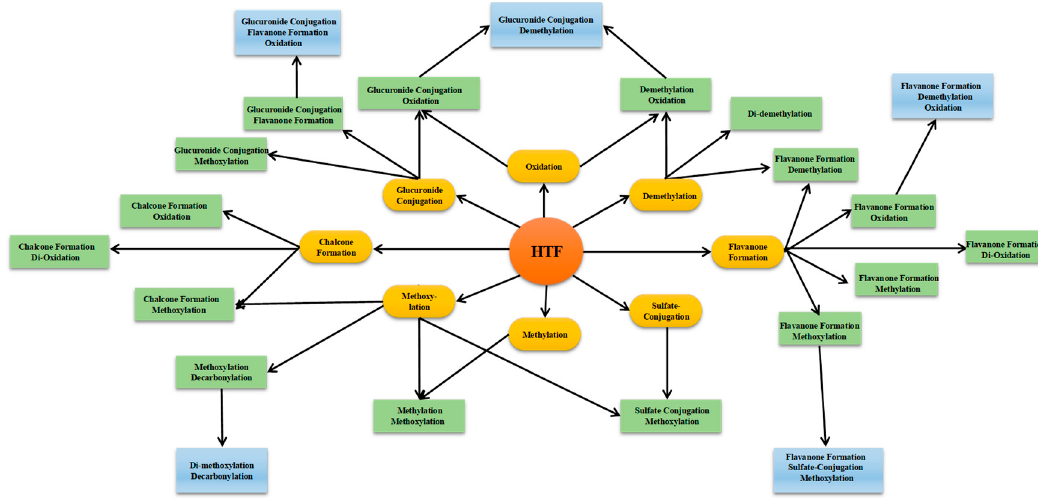
Figure 5. The proposed DMC of HTF in in vivo metabolic patterns in rats.